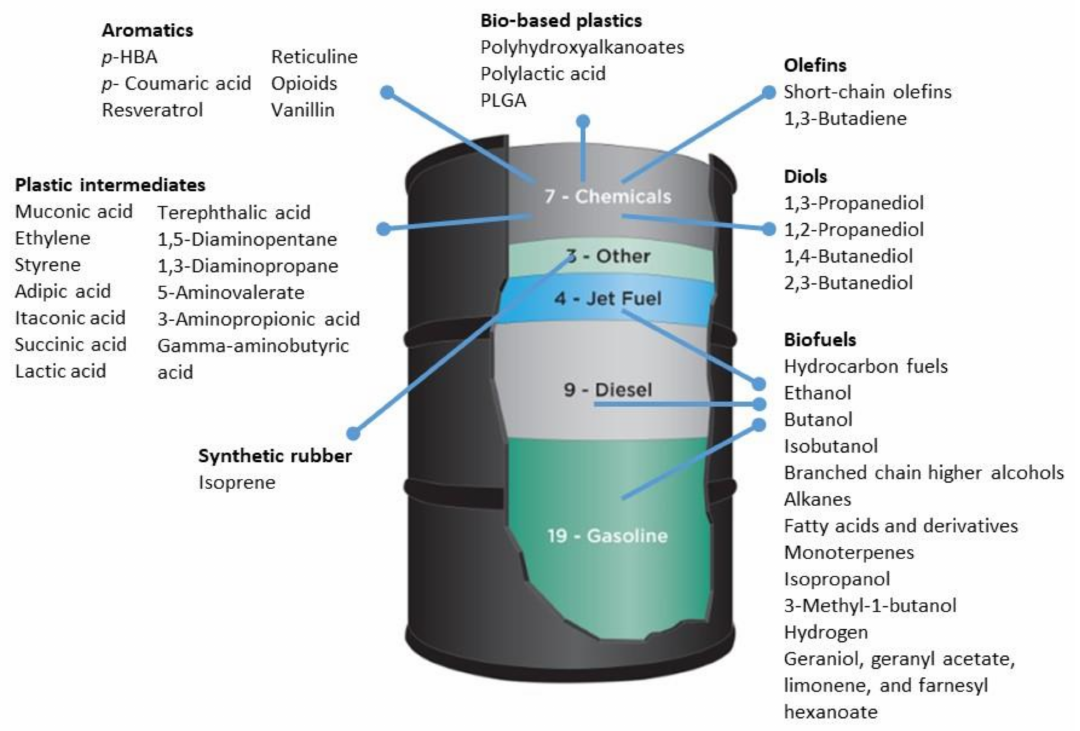
Figure 2. Replacing the oil